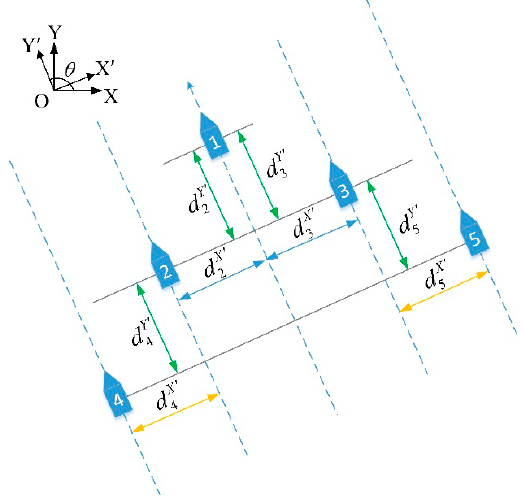
Figure 1. The standard V-shape formations for multiple unmanned surface vehicles (USVs). Every USV should keep the required distance from its immediate leader in the x -axis and y -axis according to the new coordinate frame O − X (cid:48) Y (cid:48)